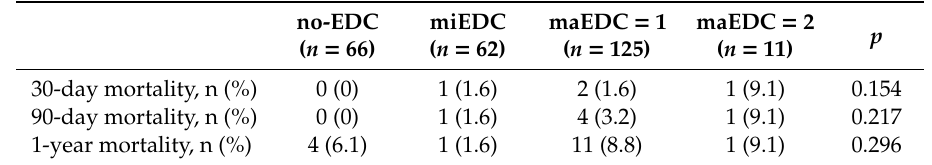
Table 4. Patient mortality following liver transplantation in patients with HCC after censoring for mortality secondary to reasons other than graft failure-related complications.